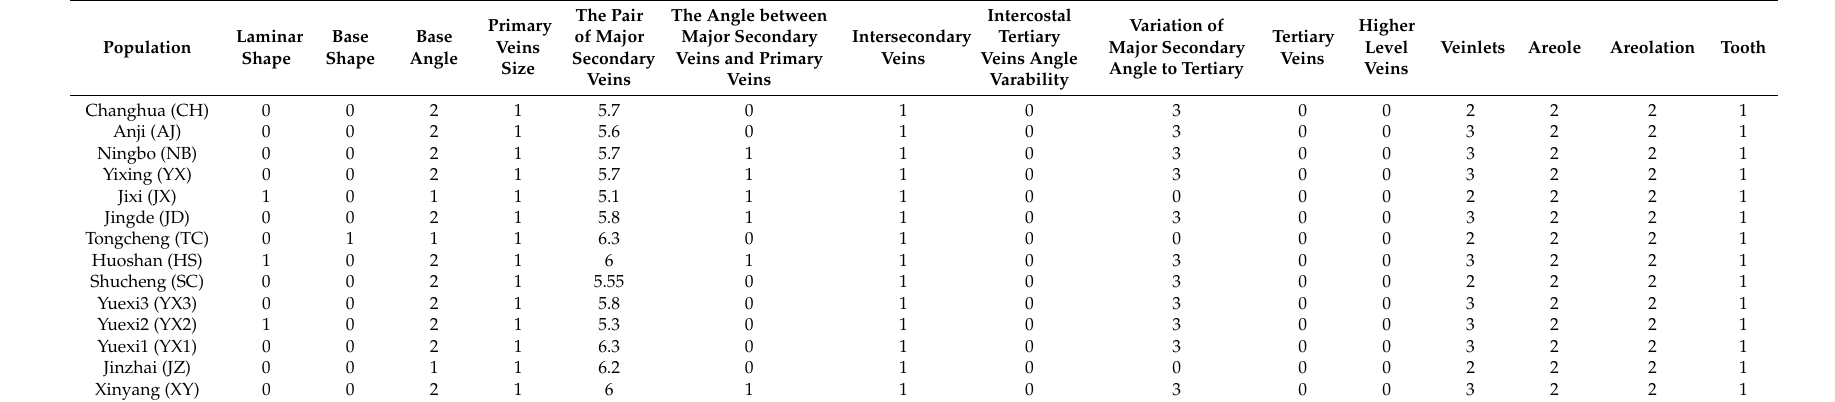
Table A1. The values of 15 leaf venation characteristics of P. subaequalis